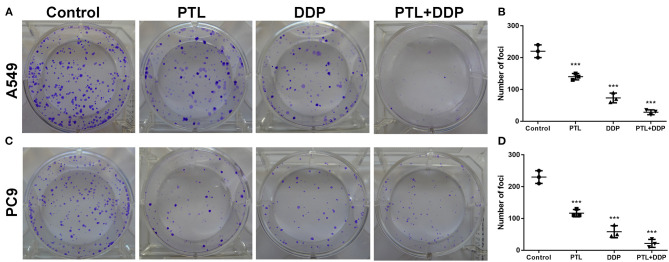
Effect of PTL and DDP alone and in combination on cell clone formation. Representative images of clone formation in A549 (A) or PC9 cells (C) following 10 days of treatment with 30 μM PTL, 0.75 μM DDP alone, and 0.2 μM DDP and 10 μM PTL in combination. Histograms depict the average clone formation of A549 (B) and PC9 (D). All data are shown as the mean ± SD of three independent experiments. ***P < 0.001 vs. the control group (magnification, × 100; scale bars, 100 μm).